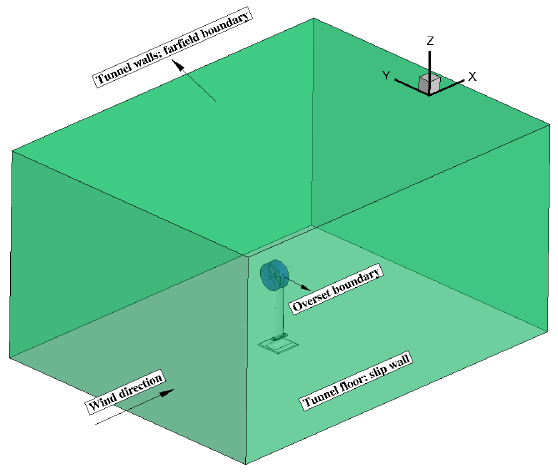
Figure 3. Wing and wind tunnel wall